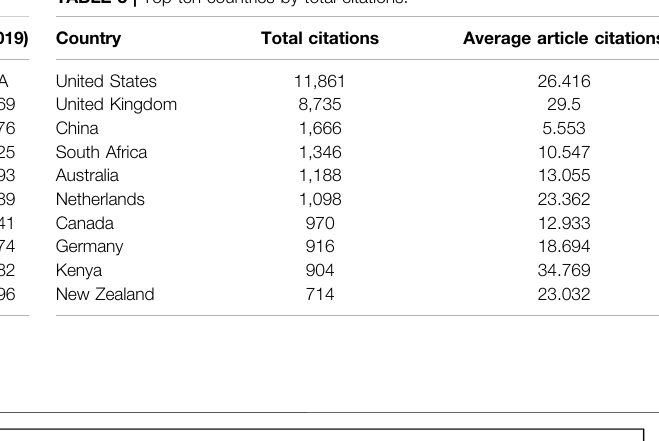
TABLE 3 | Top ten countries by total